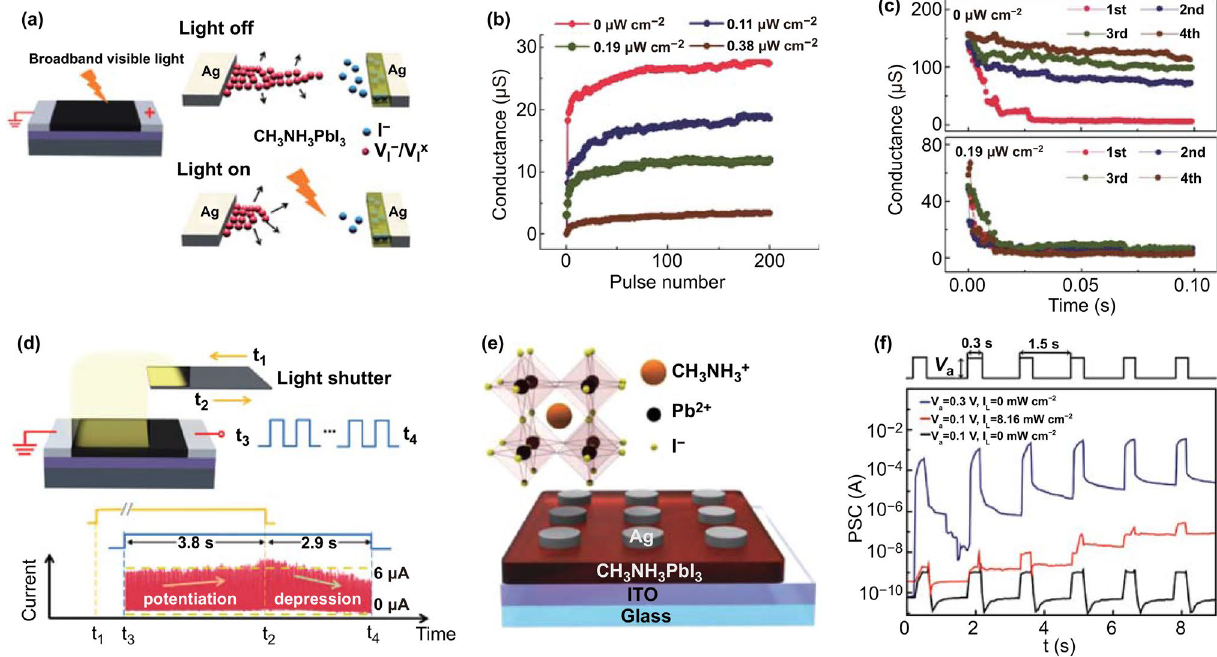
Fig. 9 a Schematic of the device and the influence of light on ion diffusion. b Changes in conductance in response to optical spikes versus the pulse number at different power densities. c Retention curves as the device is repeatedly stimulated by electrical spikes in the conditions of dark and light illumination. d Mimicking of LTP and LTD synaptic functions in the conditions of dark and light illumination. a – d Reproduced with permission from Ref. [90]. e Schematics of the Ag/MAPbI 3 (OHP)/ITO synaptic device and OHP structure. f Postsynaptic currents at different pulse conditions. e , f Reproduced with permission from Ref.